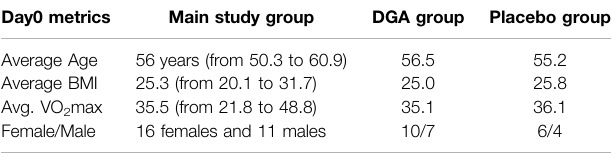
TABLE 1 | Characteristics of the study